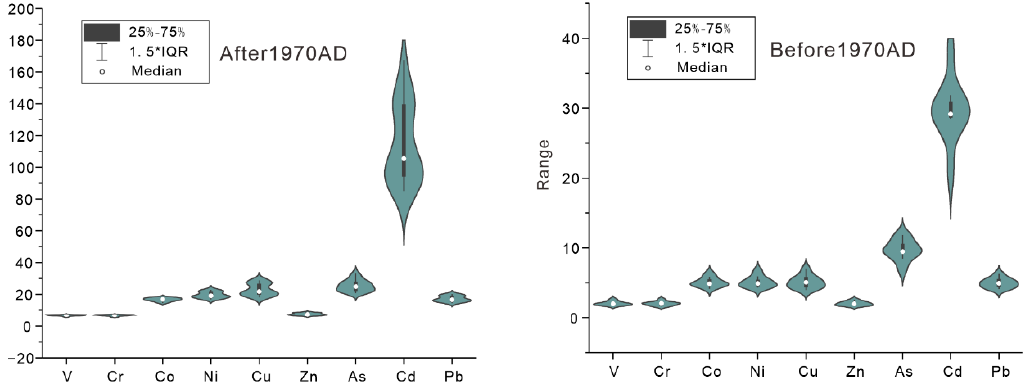
Figure 6. Violin plots for the PERI of PTEs (V, Cr, Co, Ni, Cu, Zn, As, Cd and Pb) from the lake sediments of North Aral Sea.